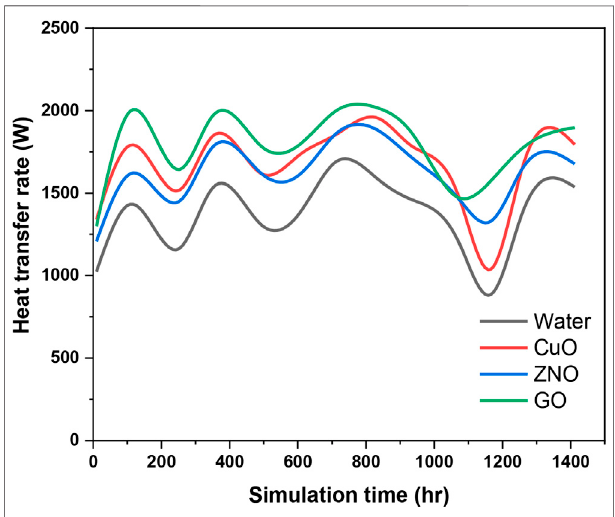
FIGURE 8 | Variations in heat transfer rate for four different working fl uids.